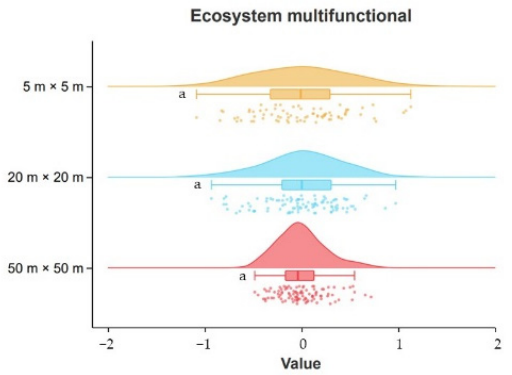
Figure 3. Characteristics and differences in ecosystem multifunctionality between scales. Note: Error lines are standard errors; same lowercase letters on the error line indicate no significant differences between data ( p > 0.05).